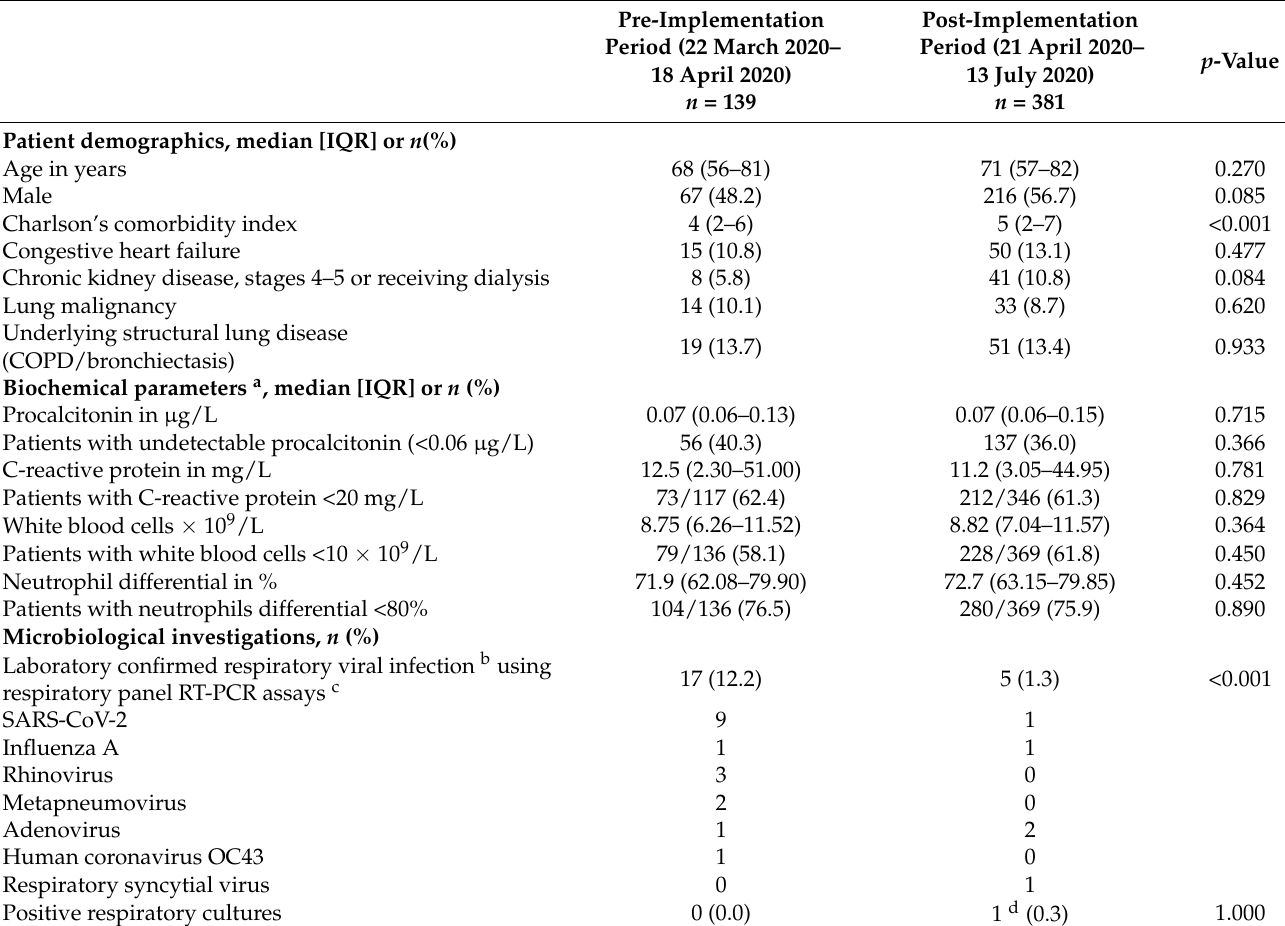
Table 1. Baseline demographics and characteristics of patients admitted for community acquired